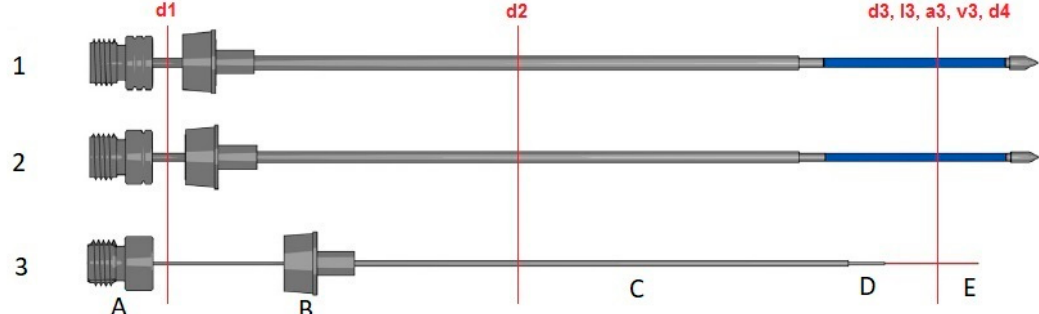
Figure 1. Solid phase microextraction (SPME) Arrows and a traditional SPME fiber; ( 1 ) 1.5 mm SPME Arrow; ( 2 ) 1.1 mm SPME Arrow; and ( 3 ) 23 gauge traditional SPME fiber. d1: Support tubing; d2: septum piercing needle; d3: phase diameter; d4: phase support tubing diameter; l3: phase length; a3: phase area; and v3: phase volume.